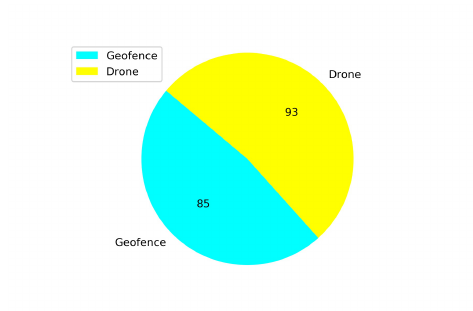
Figure 27. Crash report chart for Case 1.2 by Transfer Learning.